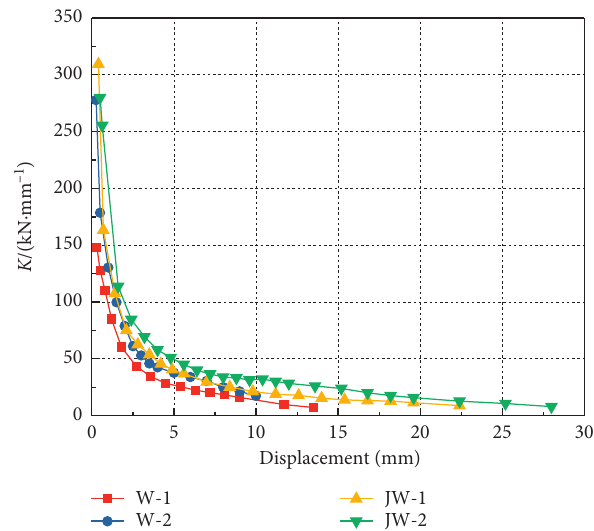
Figure 12: Stiffness degradation